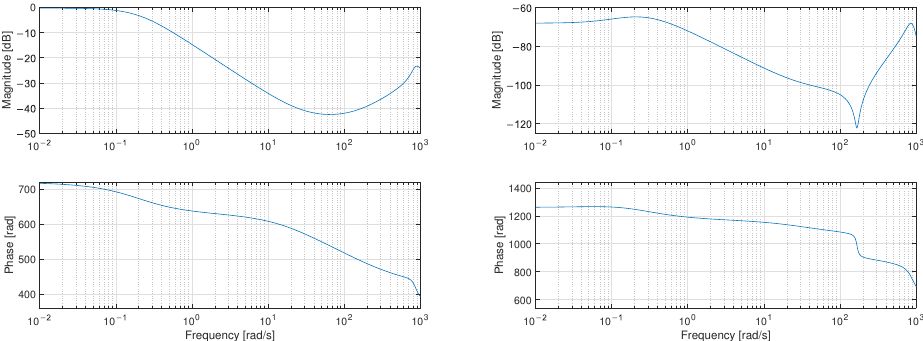
Figure 7. Frequency response of the fitted ARX model: the first transfer function ( left ) and the second transfer function ( right ).